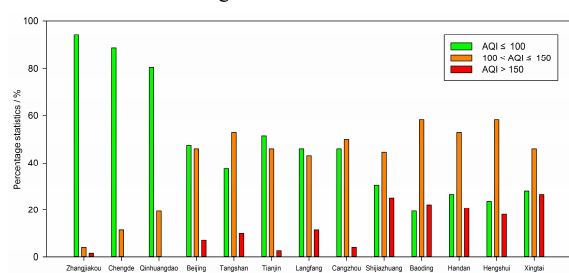
Figure 5. Spatial distribution of AOD multi-year average in BTH region from 2014 to 2018